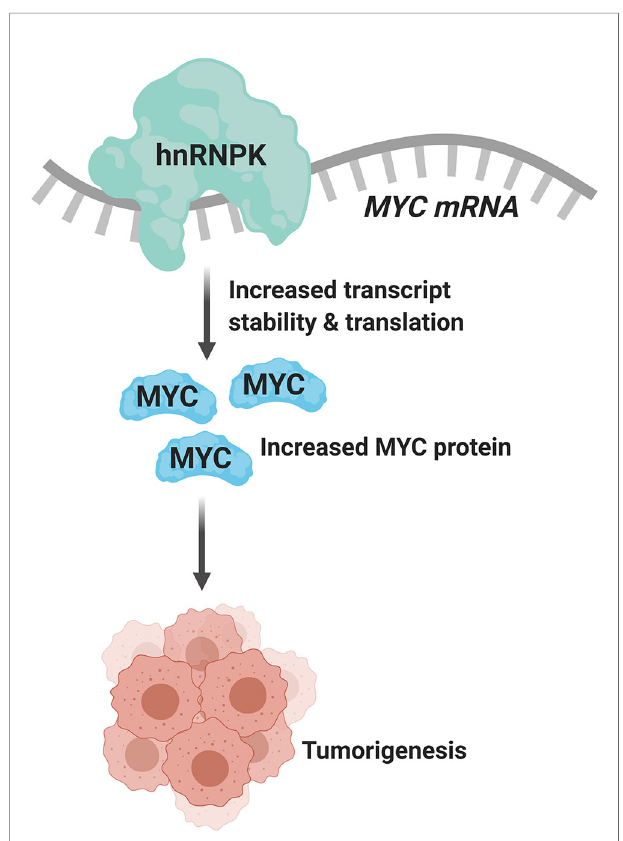
FIGURE 1 | hnRNP K binds to and regulates the stability and translation of the MYC transcript (created with